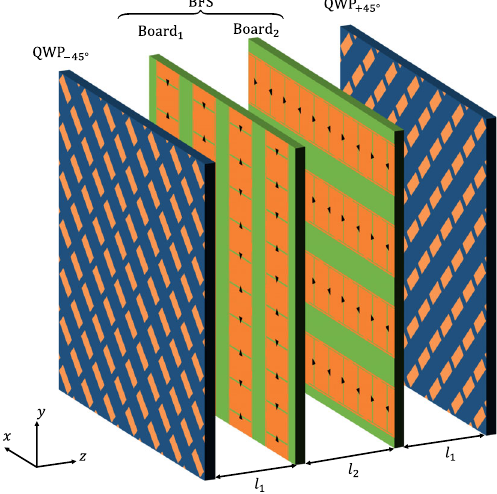
FIG. 1. Topology of the polarization rotator. The polarization rotator consists of a birefringent structure (BFS) with rotated quarter-wave plates ( þ 45 ° and − 45 ° rotated) on either side. The BFS consists of two tunable birefrigent boards (Board 1 and Board 2 ). The distances between the boards are l 1 ¼ 1 . 66 mm and l 2 ¼ 3 . 26